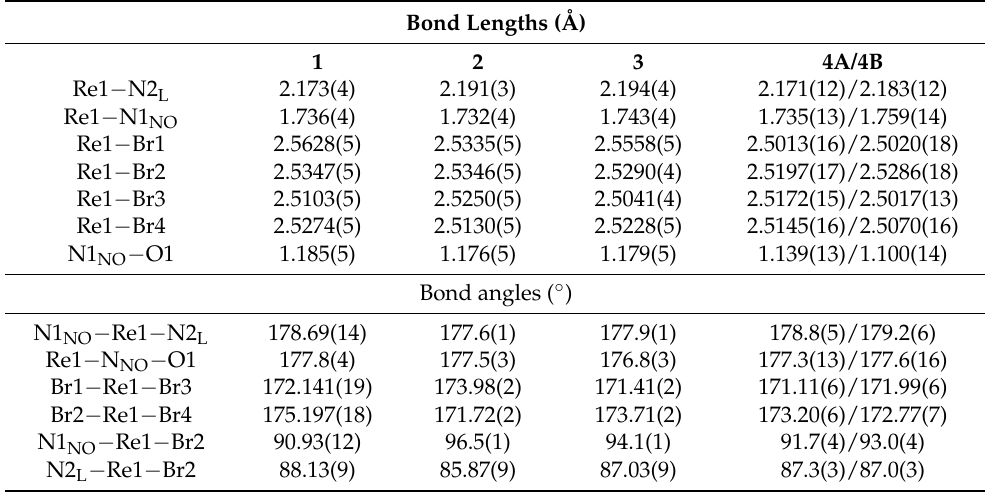
Table 1. Selected bond distances (Å) and angles ( ◦ ) for 1 – 4